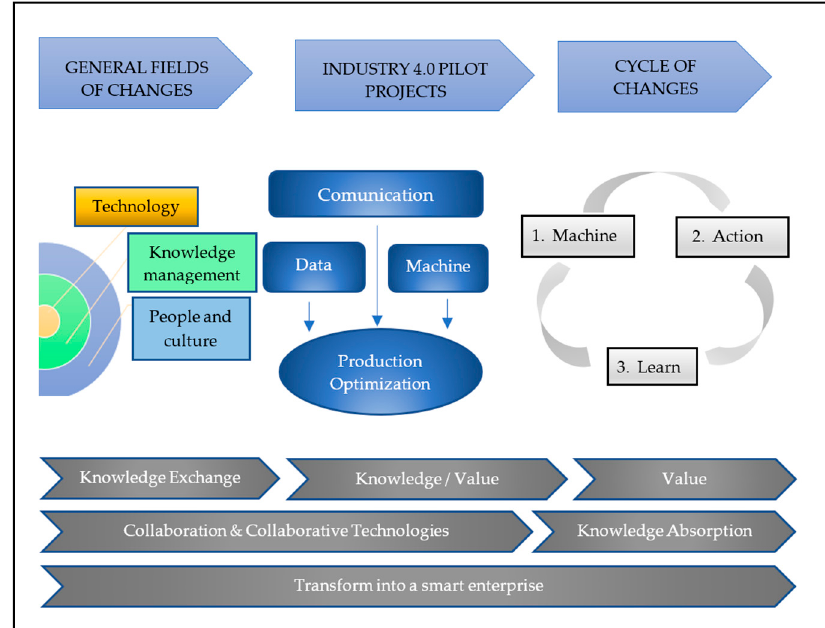
Figure 8. Industry 4.0 implementation framework. Source: own study.